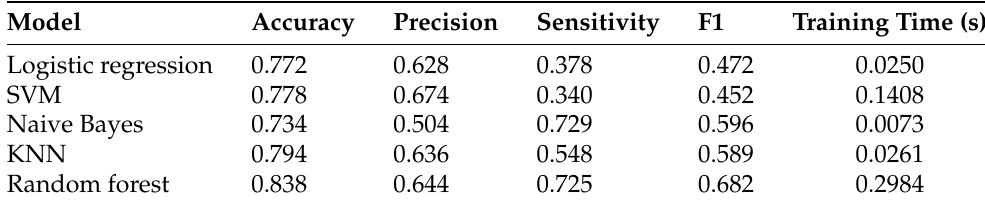
Table 1. Results of the classical ML models